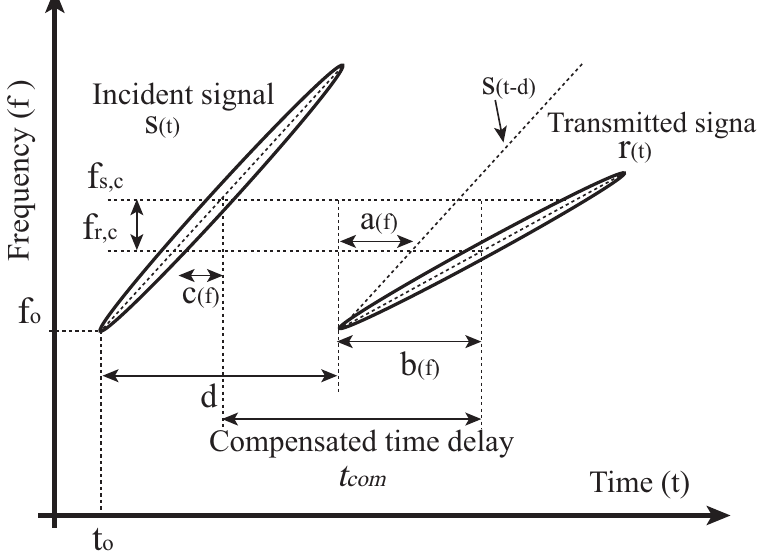
Figure 1. Illustration of compensation method based on IF